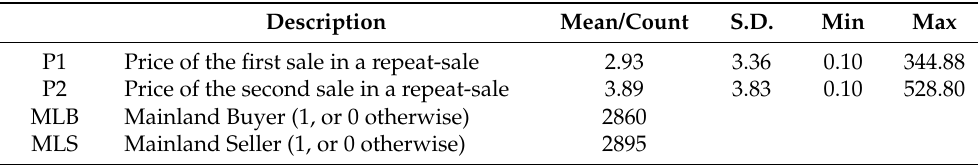
Table 4. Summary statistics of variables for the repeat-sales